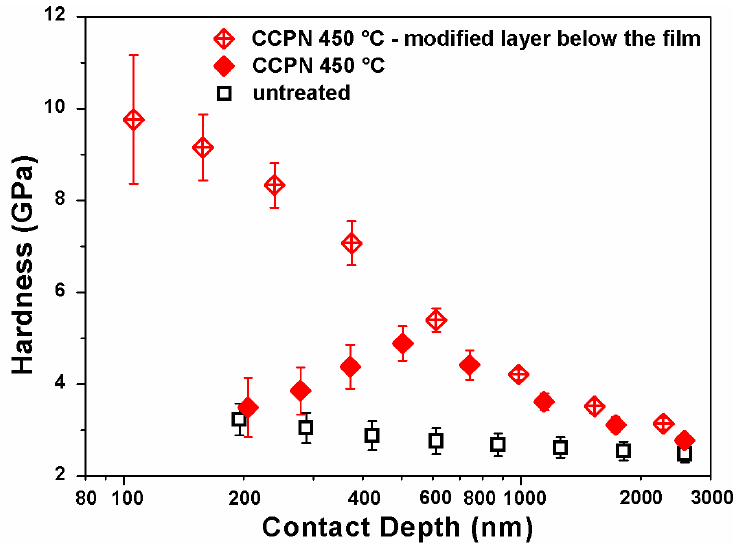
Figure 13. Hardness profiles of the CCPN 450 °C sample in the film and the region below the deposited film compared to the untreated sample.